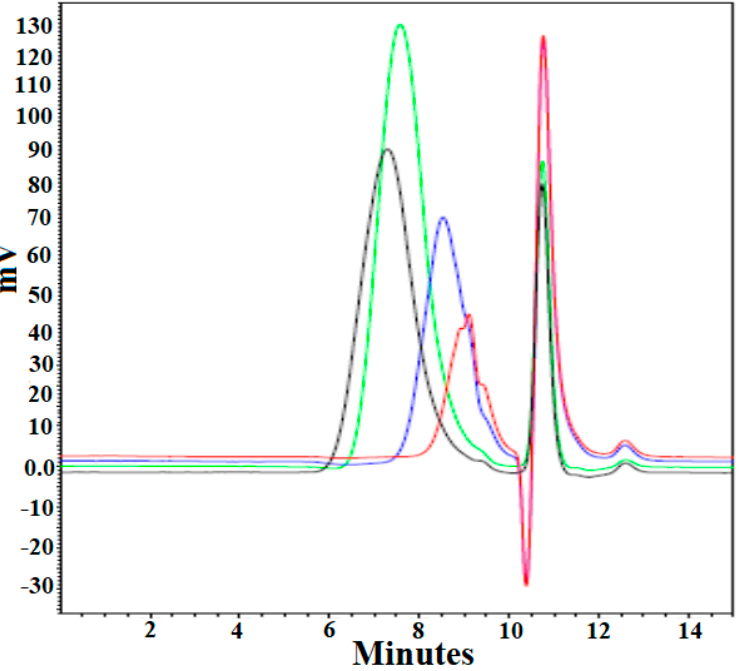
Figure 3. Overlay of GPC chromatograms of PSA synthesized by melt condensation of sebacic acid in the presence of 0.25 (red), 0.5 (blue), 1.0 (green) and 5.0 (black) (X axis is elusion time in minutes, Y axis is the intensity of absorption which translates to content).